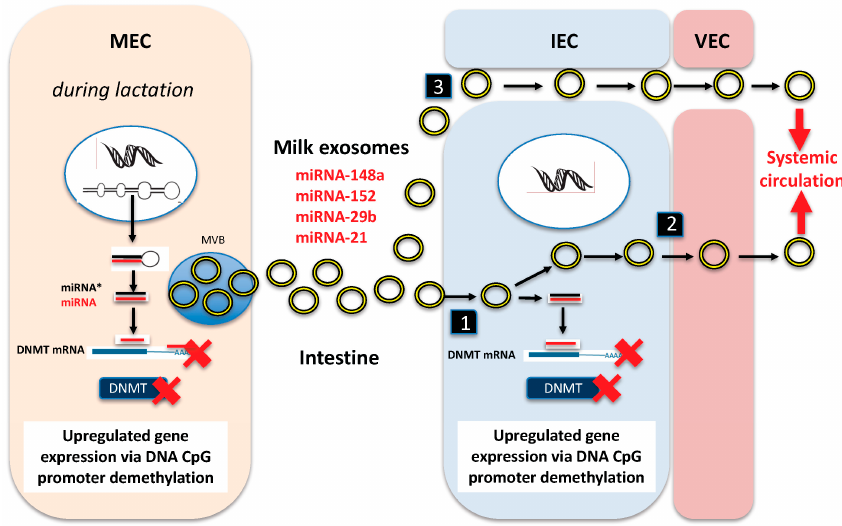
Figure 1. Working model of exosomal transfer of lactation-specific miRNAs that target DNA methyltransferases (DNMT) of the milk recipient. Mammary gland epithelial cells (MEC) secrete DNMT-targeting miRNAs via exosomes, which are taken up by (1) intestinal epithelial cells (IEC) and